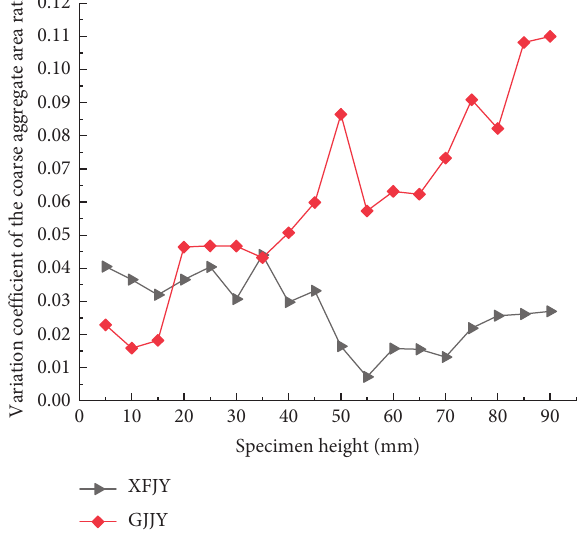
Figure 12: The void distribution characteristics of different gra- dation under vibration